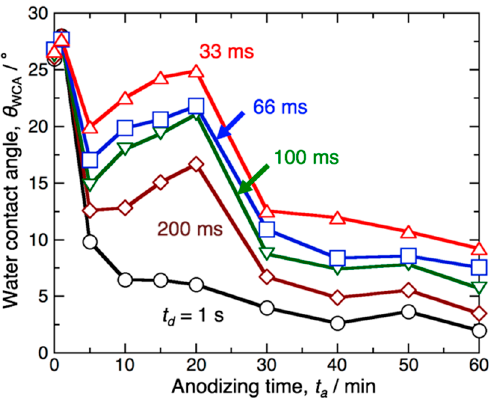
Figure 6. Change in the water contact angle measured on the anodized aluminum surface, θ WCA , with the anodizing time, t a , during the initial stage of anodizing. The electropolished specimens were anodized in pyrophosphoric acid at 283 K and 80 V.